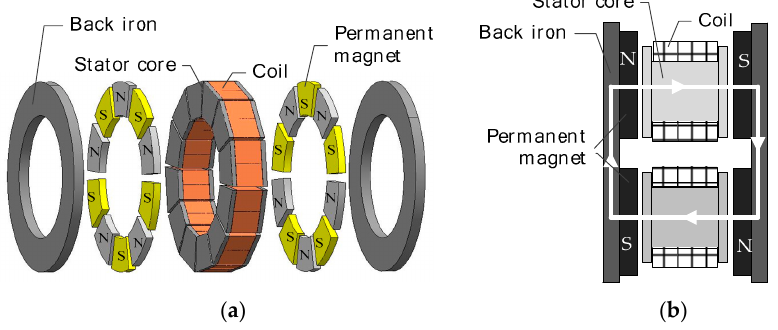
Figure 1. Structure of yokeless and segmented armature axial flux motor: ( a ) Exploded view; ( b ) Side view. Table 1. The prototype parameters.